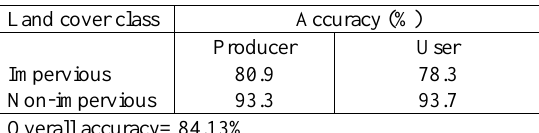
Table 5. Producer and user accuracy (ALOS/PALSAR full